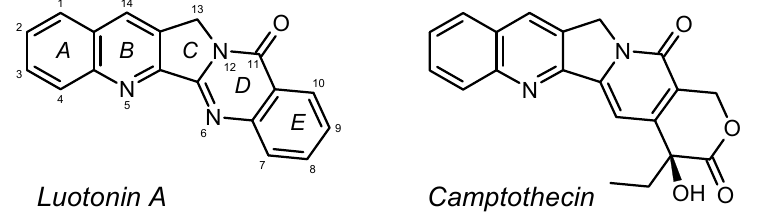
Figure 1. Structures of luotonin A (with IUPAC-conforming numbering) and